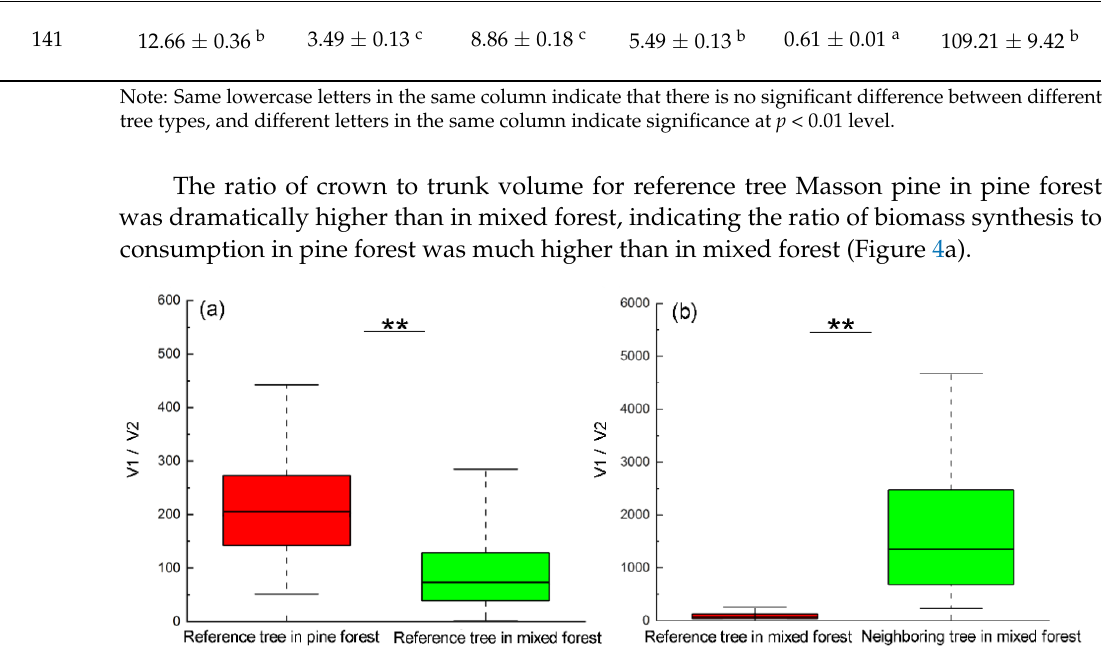
Figure 4. ( a ) The ratio of crown to trunk volume (V1/V2) for reference tree Masson pine in pine forest and mixed forest indicating the ratio of biomass synthesis to consumption. ( b ) The ratio of crown volume (V1/V2) between reference tree Masson pine and its neighboring trees in mixed forests indicating their ratio of biomass synthesis. ** indicates significance at p < 0.01 level.